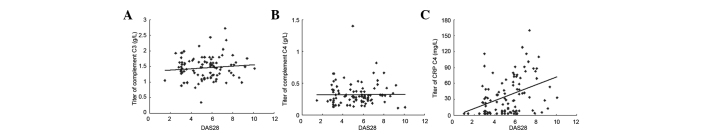
Relative analysis of changes in complements C3 and C4 and CRP with DAS28 scores in RA patients. The number of RA patients was 382. Each point represents one pair of data (x and y value). There was no significant positive and linear association of (A) complement C3 or (B) C4 titer with DAS28 score (P>0.05, r=0.014; P>0.05, r=0.099, respectively). (C) A significant positive and linear association of CRP titer with DAS28 score (P<0.05, r=0.386) is shown. CRP, C-reactive protein; SLE, systemic lupus erythematosus; RA, rheumatoid arthritis.